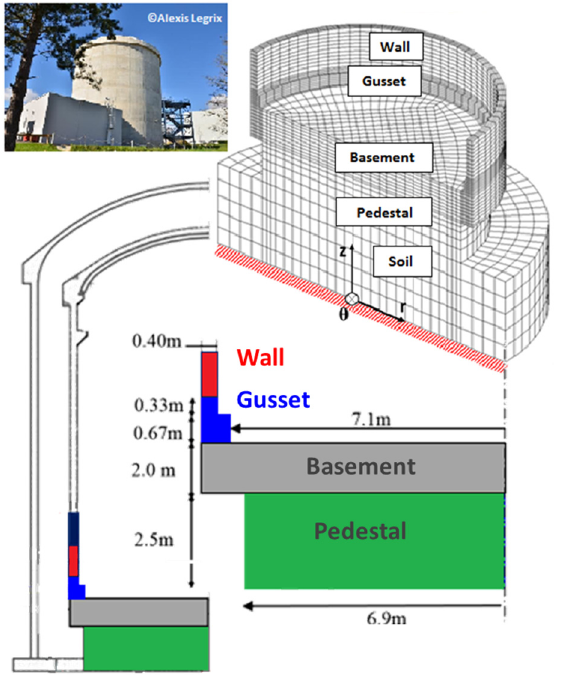
Figure 18. Geometry of Vercors mock ‐ up and details on the gusset and mesh used for the simulation (only a half is presented but the entire structure was meshed and calculated)..